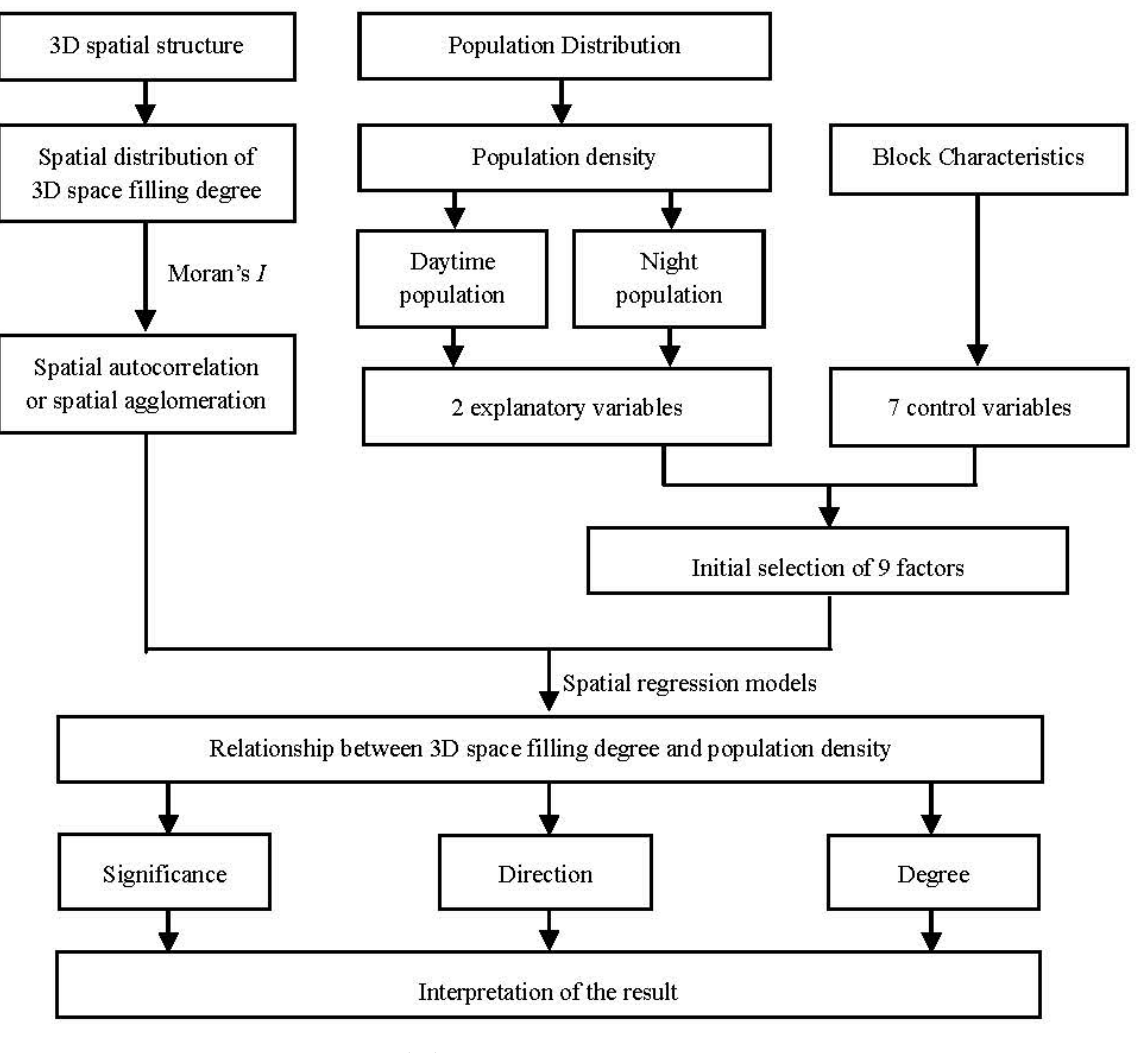
Figure 2. Research Figure 2. Research design.